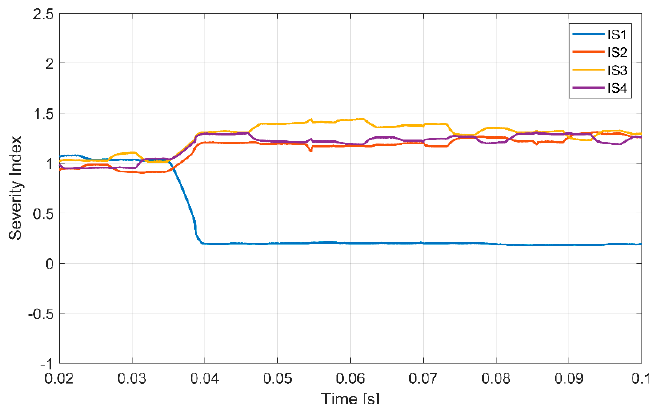
Figure 19. Diagnostic variables associated with the motor winding currents of the SRM at 600 rpm in normal operation and open-circuit failure of power device S 1 A (experimental result).